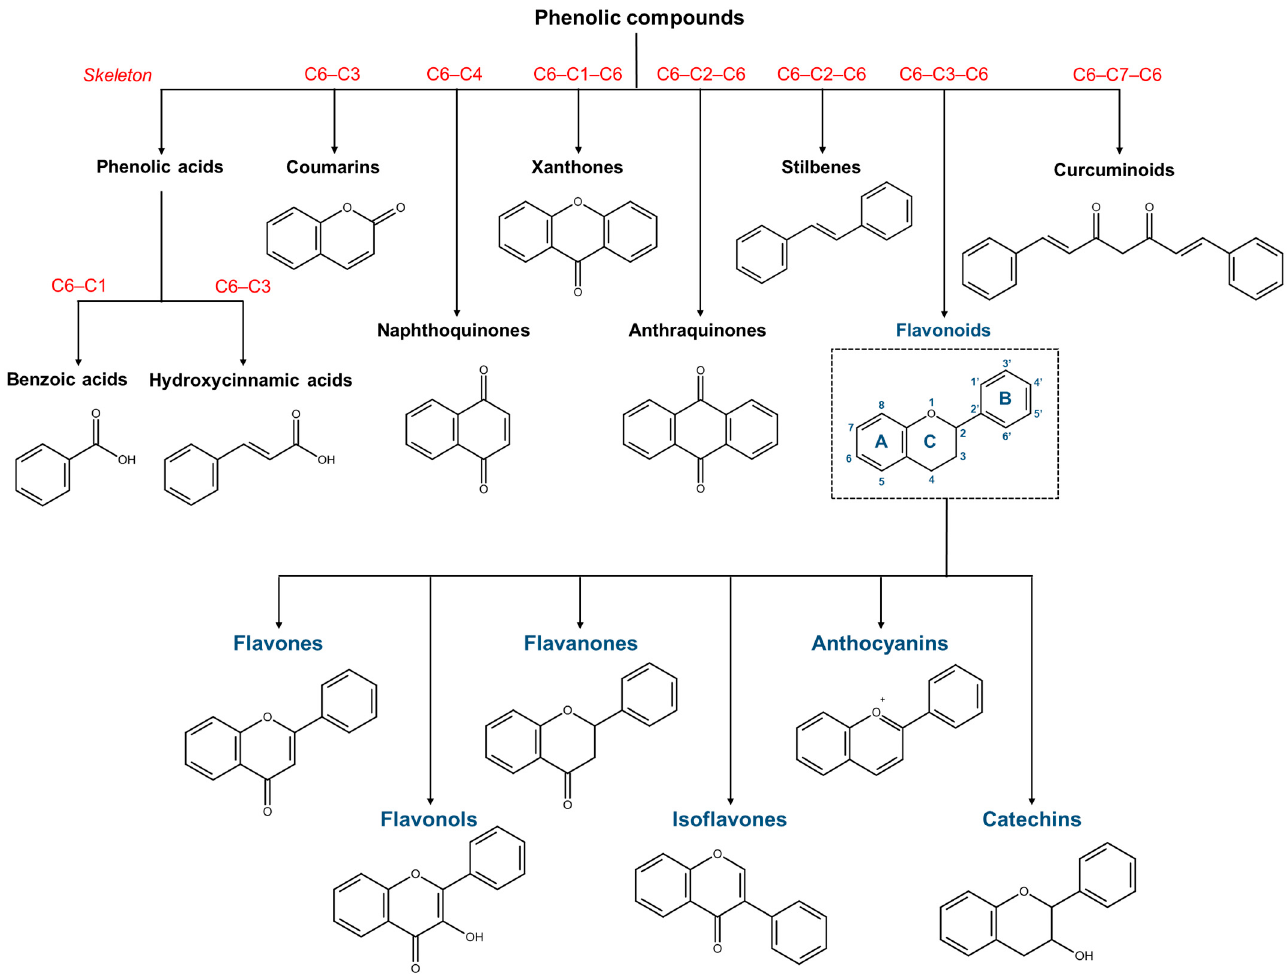
Figure 4. Classification and chemical structure of phenolic compounds. Basic skeleton structure of flavonoids and their principal classes are shown.